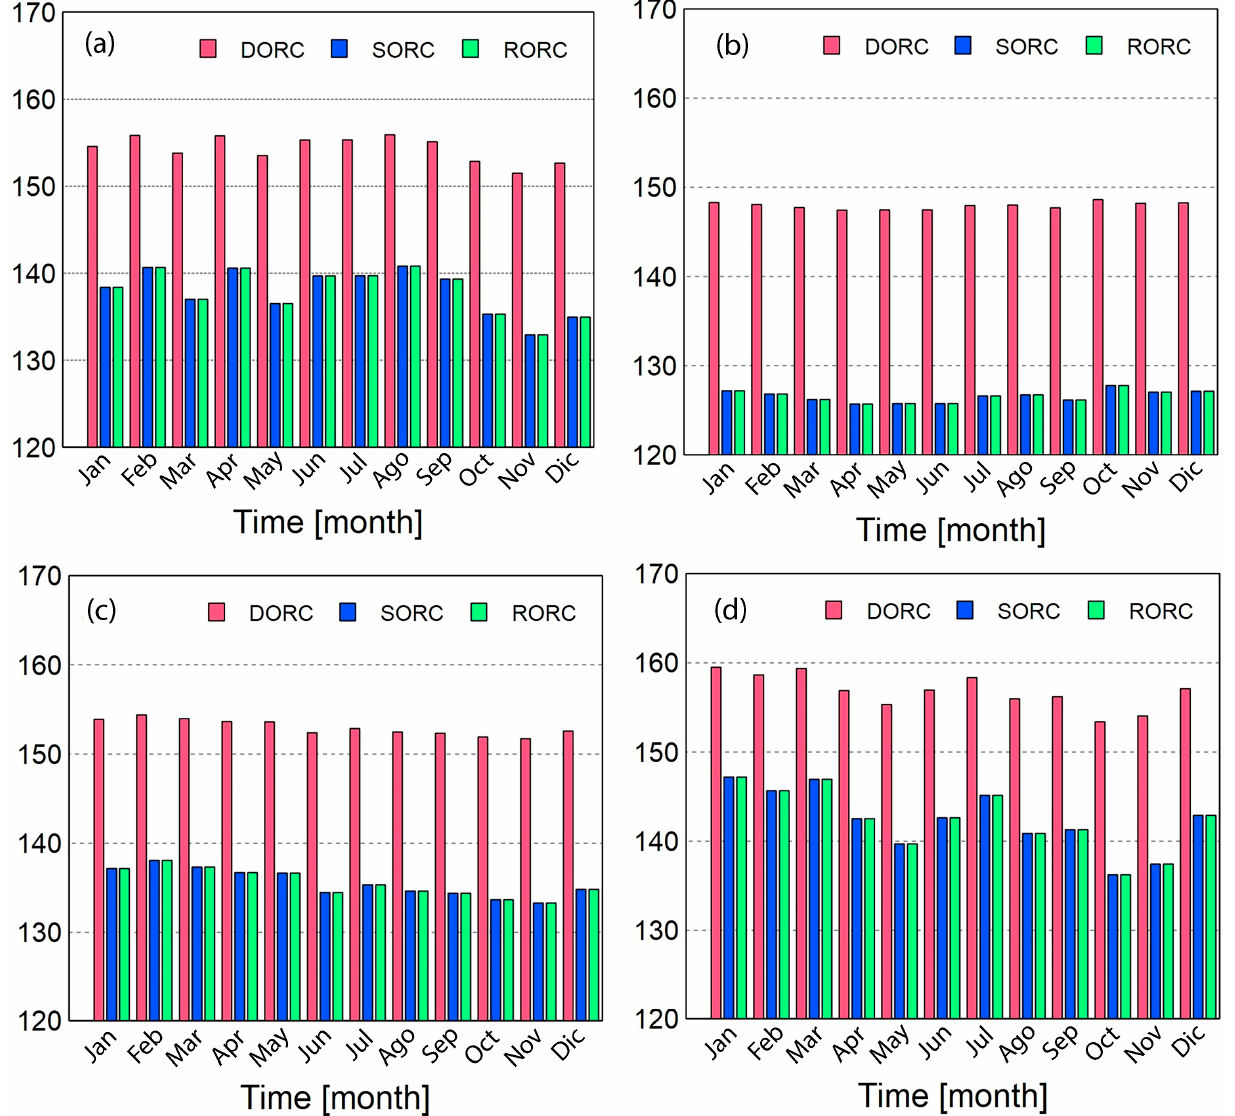
Figure 8. Daily accumulated net power for ( a ) Granja-Paici, ( b ) La Gran V í a, ( c ) Incoder, and ( d ) Las Flores.